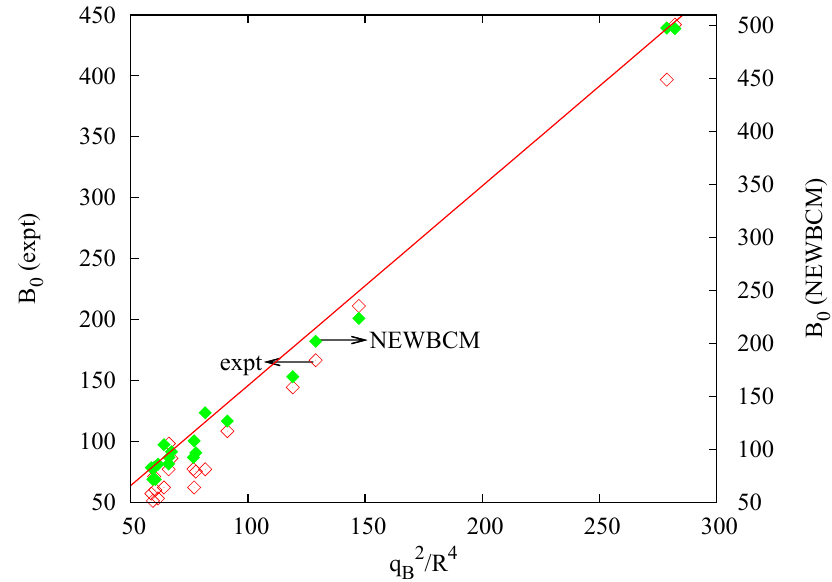
Figure 4. Experimental (empty symbols) and NEWBCM (full symbols) bulk moduli (in GPa) for IV, III–V and II–VI compounds. Bulk moduli in GPa, charge in electrons, R in atomic